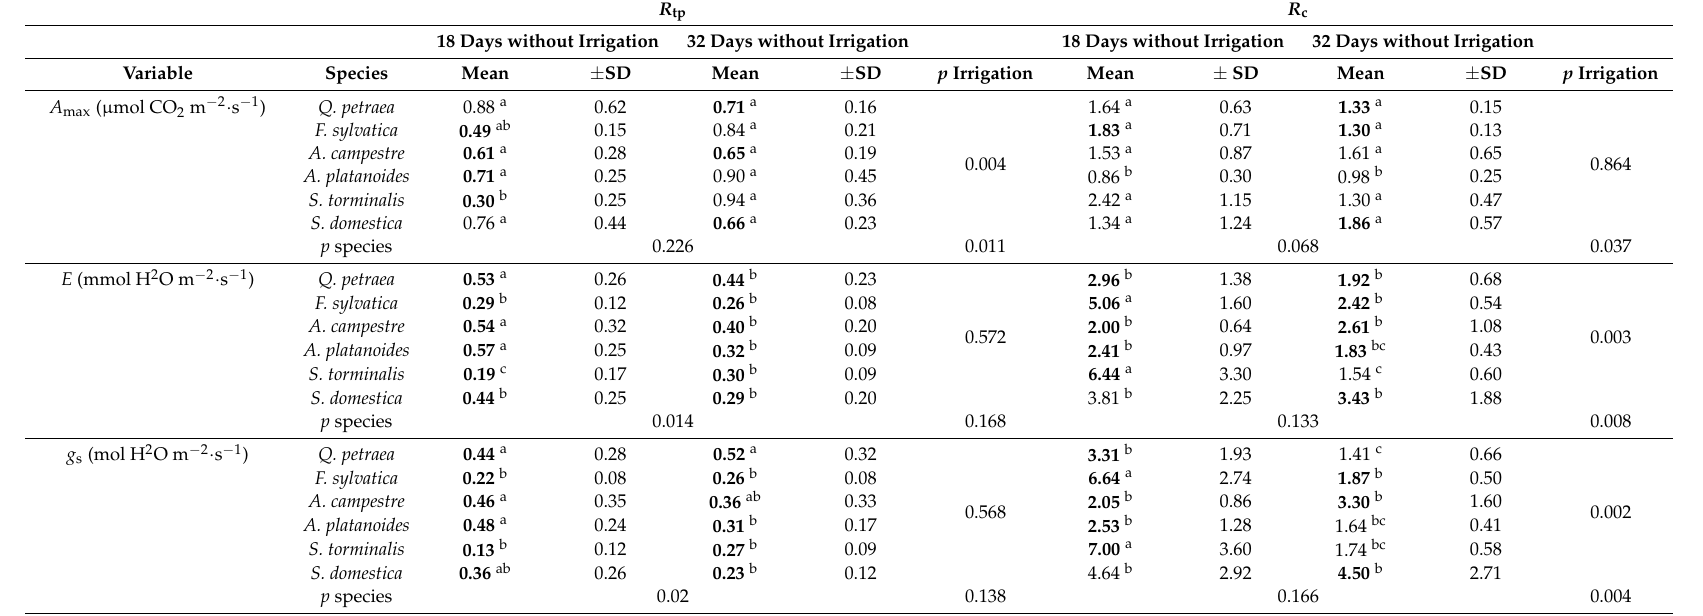
Table 5. Means and standard deviation ( ± SD) for the resistance in relation to pre-drought conditions ( R tp ), which compared physiological performance during drought with the period immediately before it, and subsequent recovery ( R c ) for maximum photosynthetic rate ( A max ), transpiration rate ( E ), and stomatal conductance to water vapor ( g s ) for control and drying/rewetting treatments of periods of 18 and 32 days without watering, respectively. Values in bold type indicate a statistically significant deviation of the indices from unity (95% of the confidence intervals do not overlap with 1). Species and treatments not sharing the same lower case letters were significantly different ( p < 0.05). Quercus petraea ( n = 36), Fagus sylvatica ( n = 34), Acer campestre ( n = 36), A. platanoides ( n = 32), Sorbus torminalis ( n = 33), and S. domestica ( n =